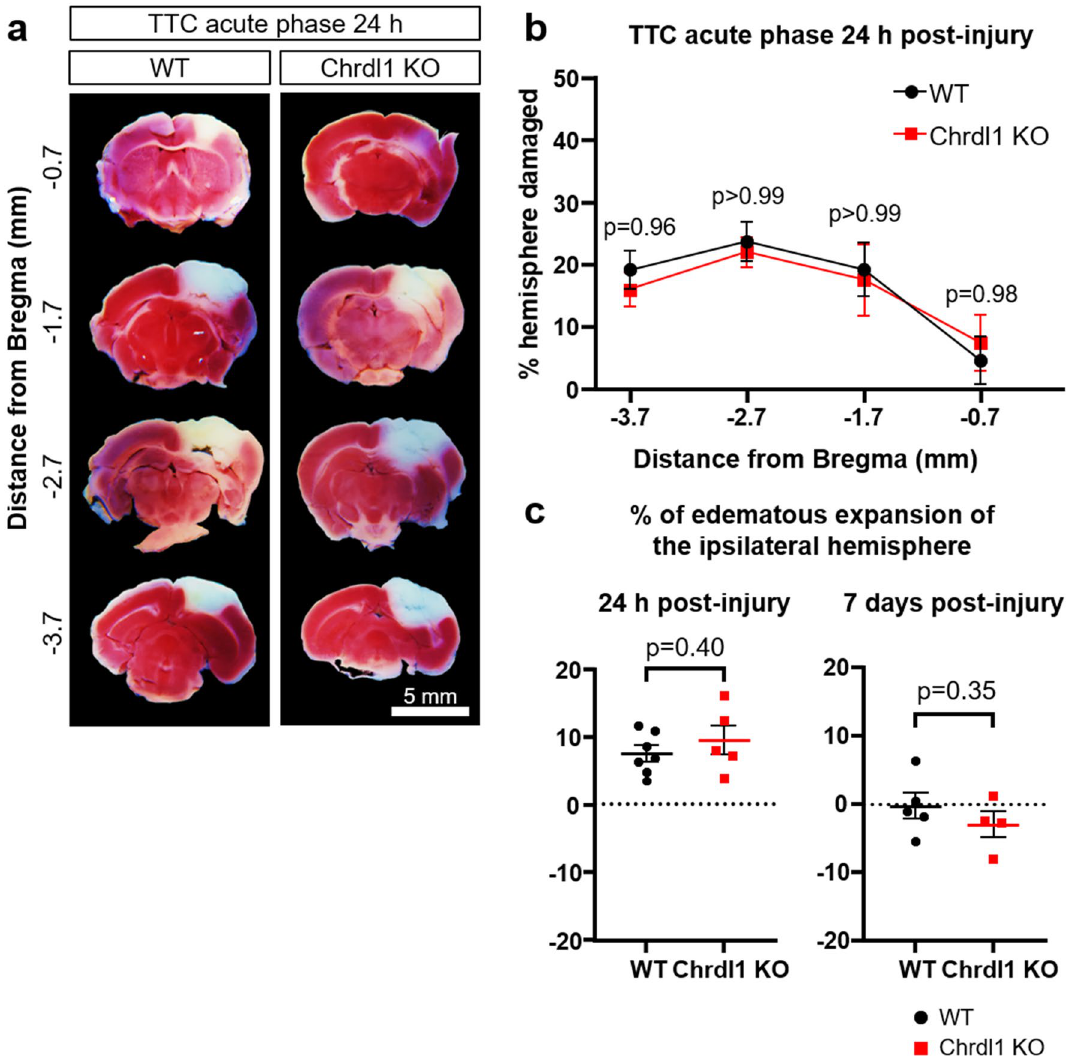
Figure 5. Absence of Chrdl1 does not affect PT injury volume. ( a ) Representative images of 1 mm-thick coronal sections of WT and Chrdl1 KO mouse brains 24 h after PT stained with TTC, corresponding to 0.7, 1.7, 2.7 and 3.7 mm posterior from Bregma. The dead tissue (brain regions infarcted) is not stained by TTC and appears white, whereas the rest of the tissue turns a shade of red. Scale bar 5 mm. ( b ) Quantification of the volume of the injury as percentage of the total volume of the ipsilateral hemisphere. WT N = 7, Chrdl1 KO N = 5 mice. Statistics by two-way repeated measures ANOVA. ( c ) Post-injury edematous expansion of the ipsilateral hemisphere represented as % relative to the total volume of the contralateral hemisphere at 24 h or 7 days post- injury. 24 h post-injury: WT N = 7, Chrdl1 KO N = 5 mice; 7 days post-injury: WT N = 5, Chrdl1 KO N = 4 mice. Statistics by unpaired spines and considered to establish strong synaptic connections, as opposed to those with thin and stubby mor- phologies that are highly dynamic and predominant during developmental stages and plasticity processes 39,40 . One possibility is that Chrdl1 KO mice experience spine loss with a fast turnover during the early acute phase (first 24 h post-injury), in which case an increase in immature spine morphologies would be expected compared to mice that went under sham surgeries. We found that WT mice showed a significant decrease in mature spines after injury (Fig. 7d, WT sham 0.33 ± 0.02 protrusion/µm; WT PT 0.10 ± 0.03 protrusion/µm). Chrdl1 KO did not show any alterations in mature spine density in the peri-infarct area during the acute phase (Fig. 7d, Chrdl1 KO sham 0.31 ± 0.06 protrusion/µm; Chrdl1 KO PT 0.33 ± 0.04 protrusion/µm). During the acute phase, WT mice also showed a decrease in immature spine density (Fig. 7e, WT sham 0.84 ± 0.08 protrusion/µm; WT PT 0.40 ± 0.08 protrusion/µm), whereas Chrdl1 KO mice had a constant density of immature spines after injury compared to sham animals (Fig. 7e, Chrdl1 KO sham 0.79 ± 0.12 protrusion/µm; Chrdl1 KO PT 0.89 ± 0.13 protrusion/µm). During the sub-acute phase, the WT mice showed restoration of mature spine density (Fig. 7h, WT sham 0.28 ± 0.06 protrusion/µm; WT PT 0.20 ± 0.01 protrusion/µm), while the Chrdl1 KO mice showed no changes in the mature spine density (Fig. 7h, Chrdl1 KO sham 0.31 ± 0.08 protrusion/µm; Chrdl1 KO PT 0.29 ± 0.06 protrusion/µm). On the other hand, density of immature spines in the WT mice during the sub-acute